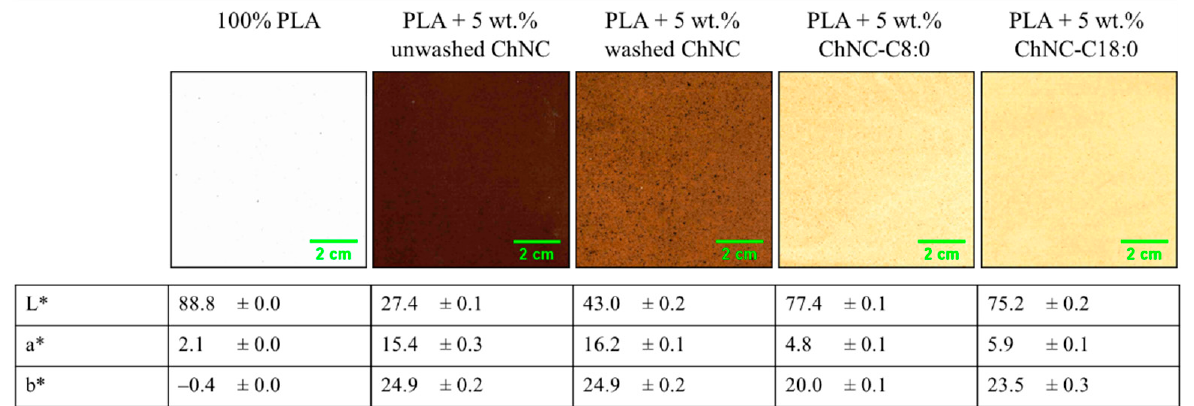
Figure 5. Scanning electron microscopy pictures of PLA containing ( A ) 5 wt.% unwashed ChNC, ( B ) 5 wt.% ChNC-C8:0, ( C ) 5 wt.% washed ChNC, ( D ) 5 wt.% ChNC-C18:0. ( E ) Samples containing ChNC-C8:0 and ChNC-C18:0 had many small aggregates with a size of ~500 nm.